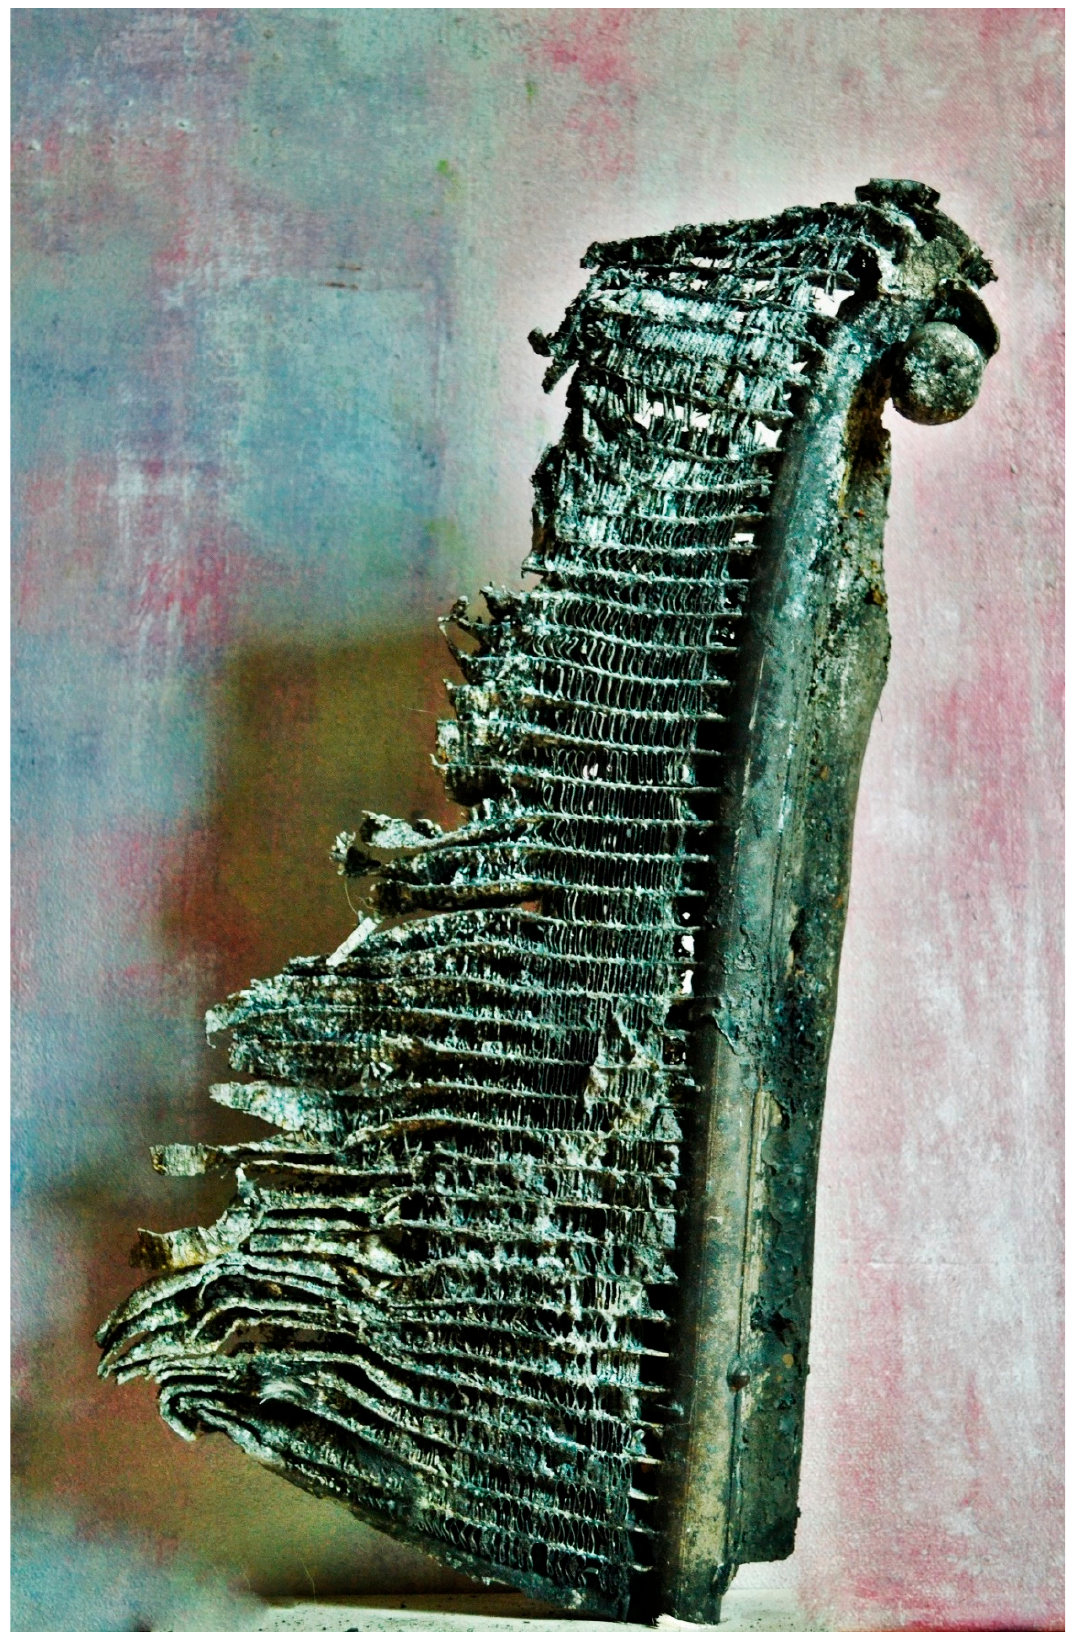
Figure 3. Blown in the Wind. Photo by Agricubismo ® .